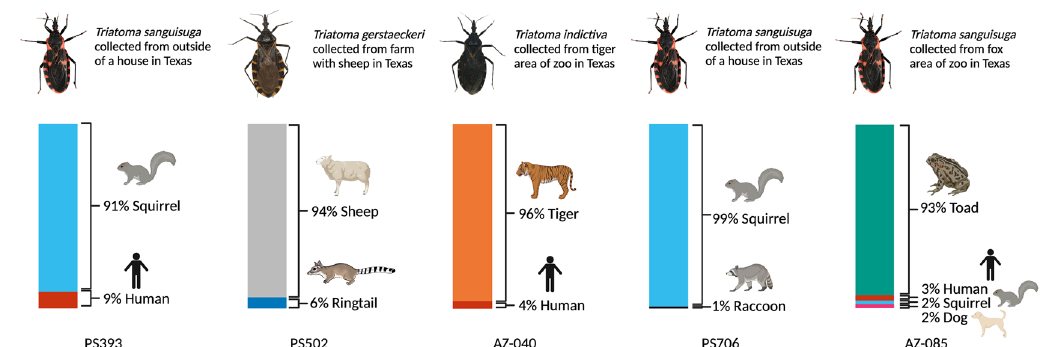
Figure 1. Amplicon deep sequencing revealed multiple bloodmeal sources in several triatomines. DNA extracted from triatomine hind guts was subjected to amplicon deep sequencing. Of the 36 samples generating amplicon deep sequencing results, 5 samples generated results revealing more than one bloodmeal source. One of the five samples had four bloodmeal sources identified. Ringtail image created by Dr. Tara Roth. Figure created with https:// biore nder. com/.